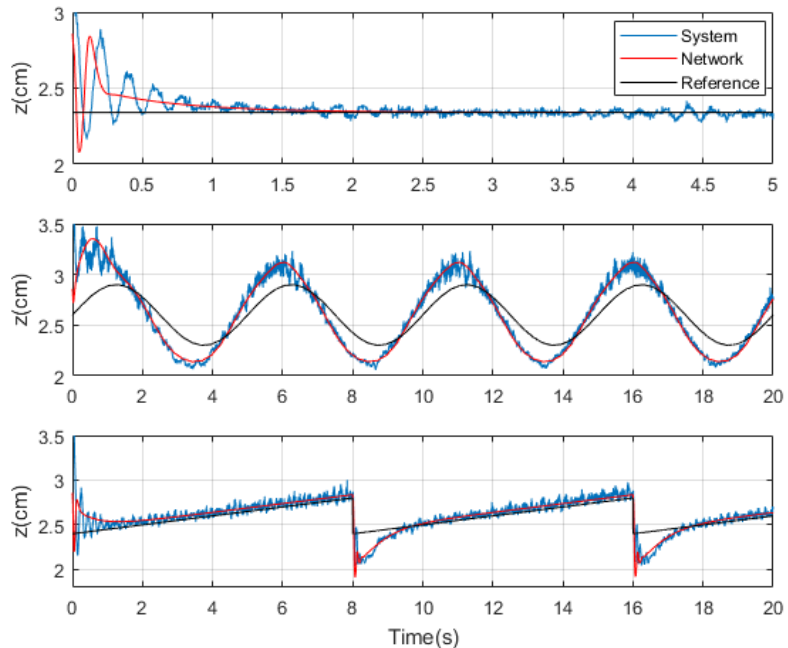
Figure 14. Comparison between the system and the network